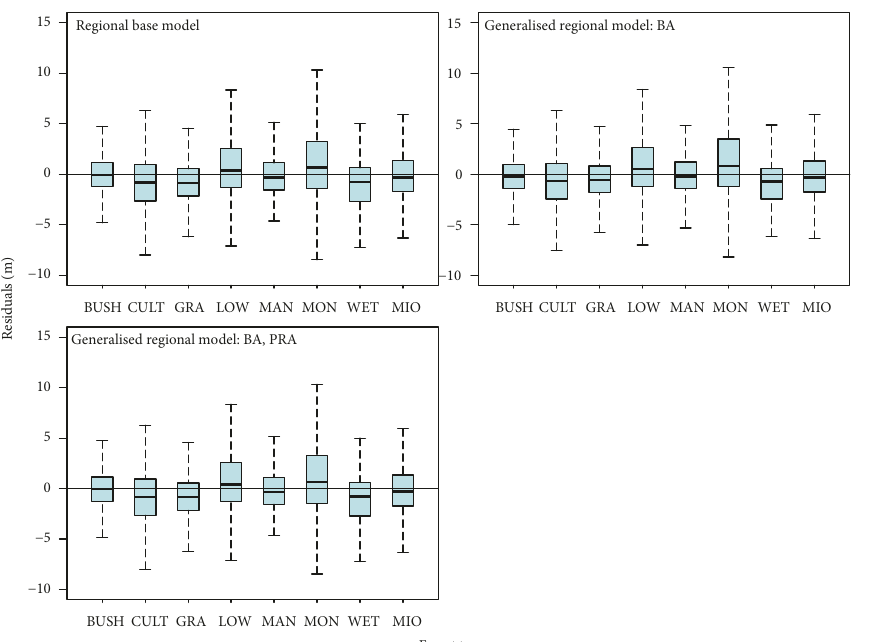
Figure 6: Evaluation of regional models to the studied from types BUS: Bushland; GRA: Grassland; LOW: Lowland; MAN: Mangroves; MIO: Miombo; MON: Montane; and WET: Wetlands.